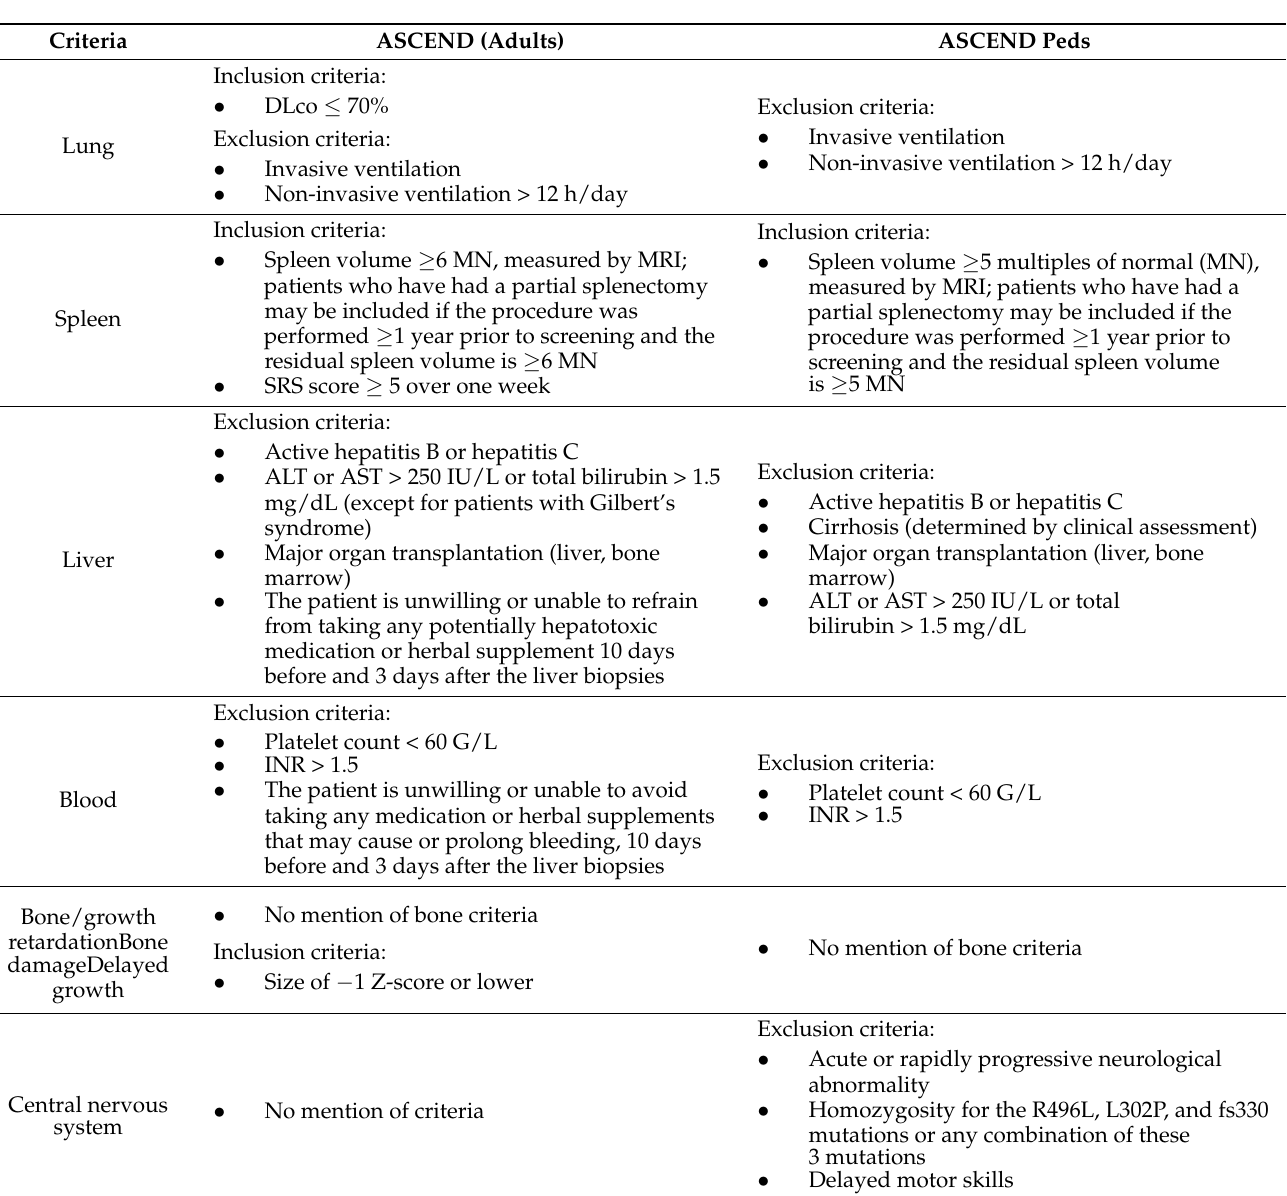
Table 5. Criteria in ASCEND (adults and peds) study for use of olipudase